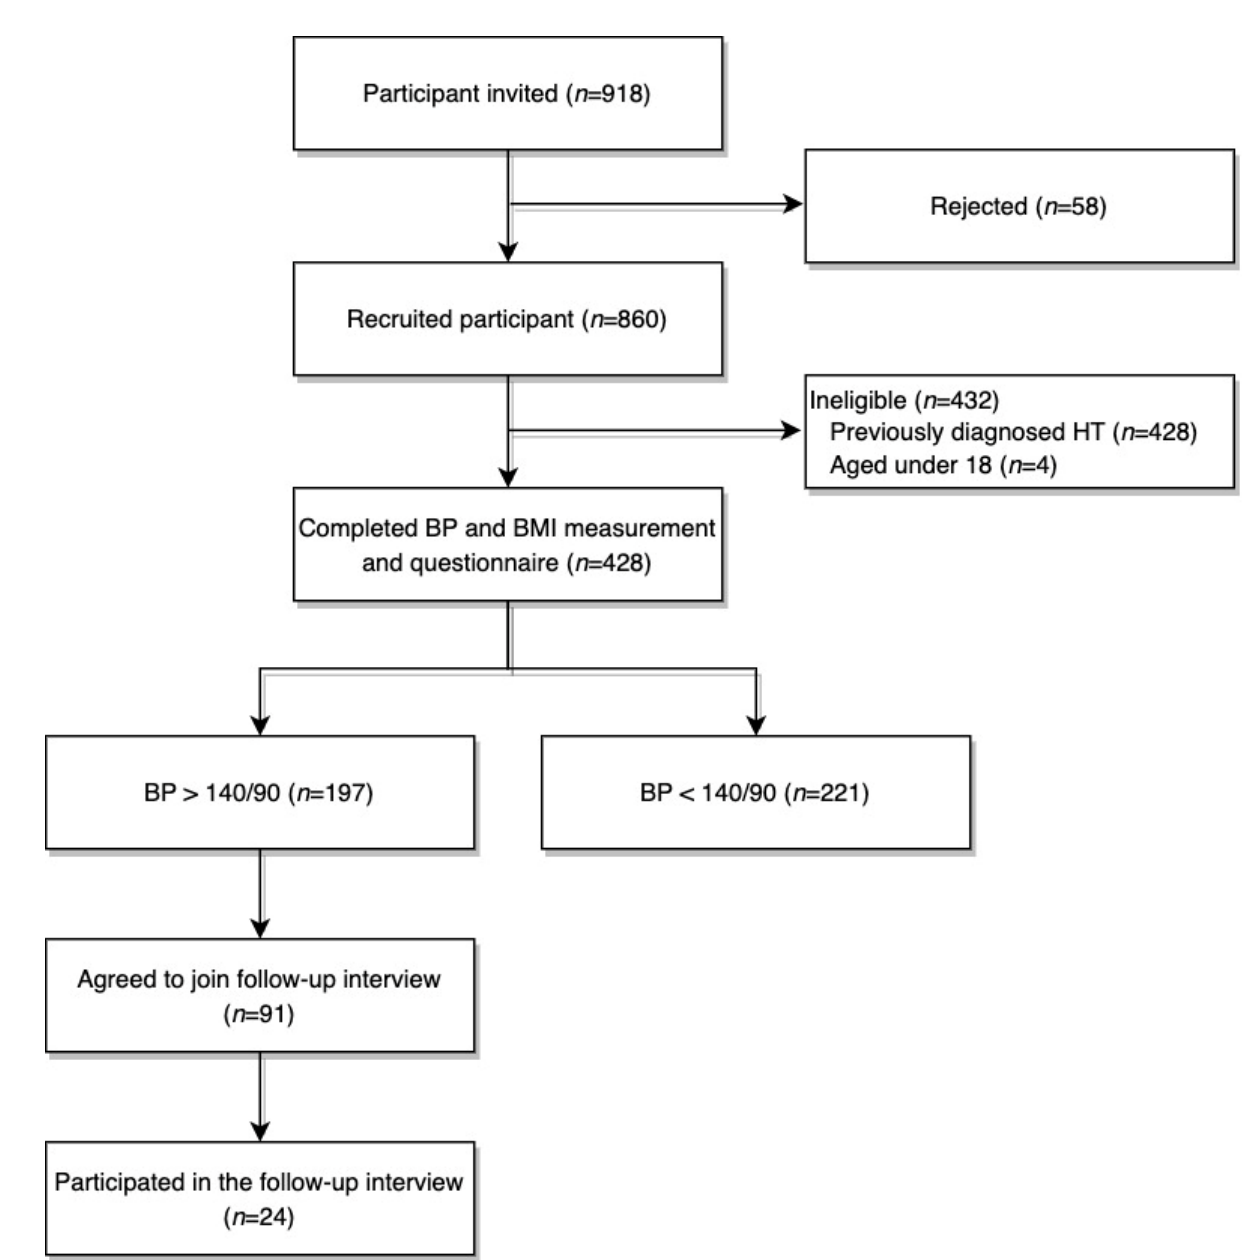
Figure 1. Number of participants at each stage of the study. The mean age and BMI of the participants were 56.2 ± 15.6 years and 24.2 ± 3.7 kg/m 2, respectively. Most participants were female (50.7%), were employed (46.7%), received at least secondary education (70.1%), were married (80.1%), were without self-reported chronic diseases (71.0%), were never smokers (82.2%), were never drinkers (71.5%) and were without health insurance (70.8%). Most did not have a regular family doctor (87.9%) but had visited a doctor in the previous two years (71.7%) (Table